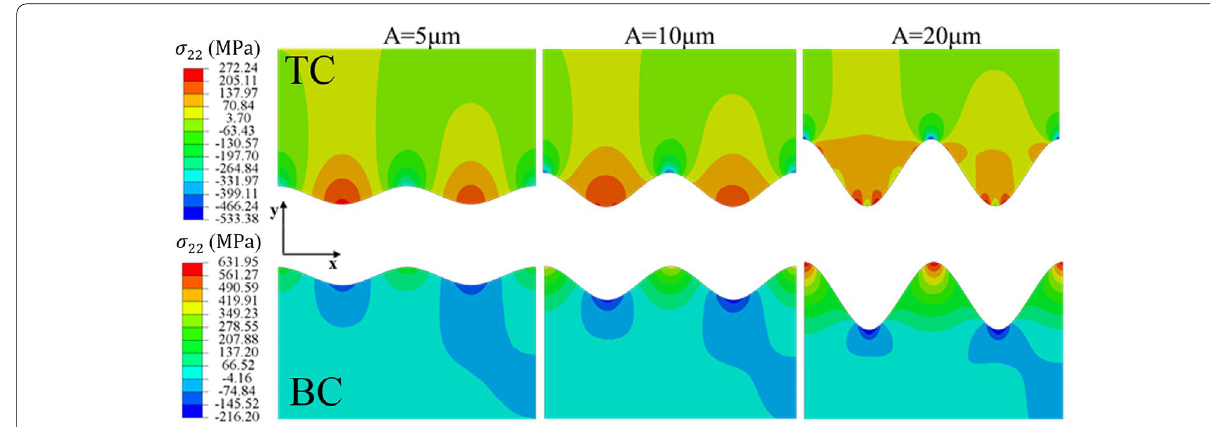
Figure 15 Distribution of σ 22 in TC and BC layers of Zone II under different interface amplitudes